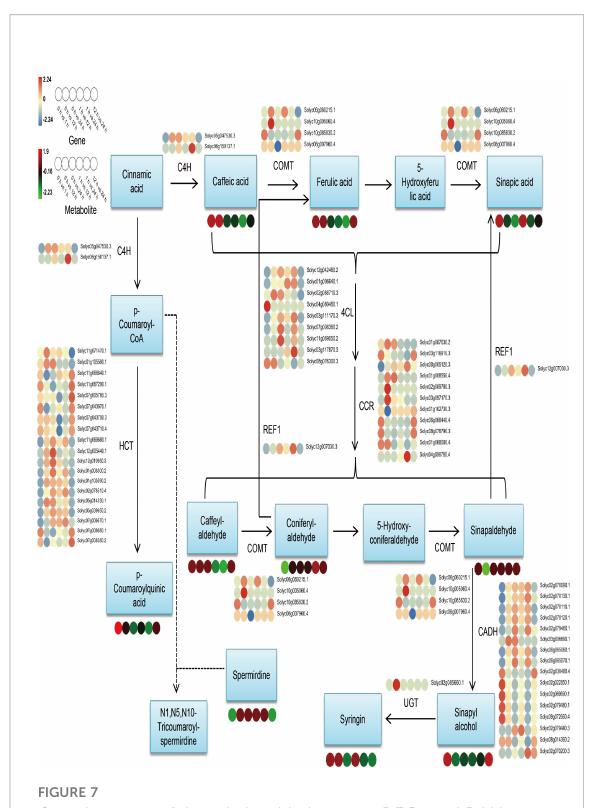
FIGURE 7 Overview map of the relationship between DEGs and DAMs within the phenylpropanoid biosynthesis pathway in S. lycopersicum roots under salt stress. The colored circles at the bottom show the heatmap of expression of key metabolites and transcripts associated with phenylpropanoid biosynthesis in different comparison groups. Key enzyme gene abbreviations: C4H, Cinnamate 4-monooxygenase; COMT, Caffeic acid 3-O- methyltransferase; CCR, Cinnamoyl-CoA reductase; 4CL, 4- coumarate – CoA ligase; HCT, Shikimate O- hydroxycinnamoyltransferase; REF1, Coniferyl-aldehyde dehydrogenase; UGT, Coniferyl-alcohol glucosyltransferase; CADH, Cinnamyl-alcohol